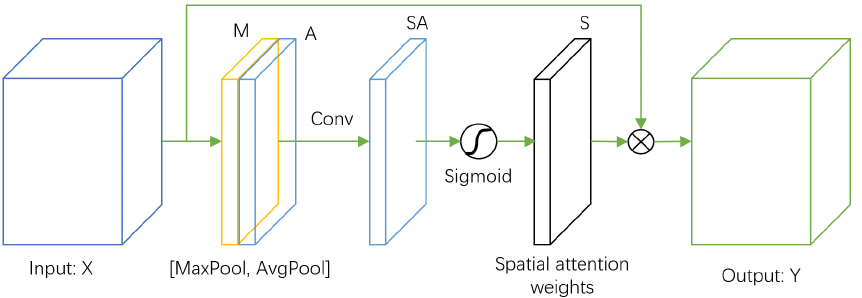
Figure 3. Pooling loss detail enhancement processing.